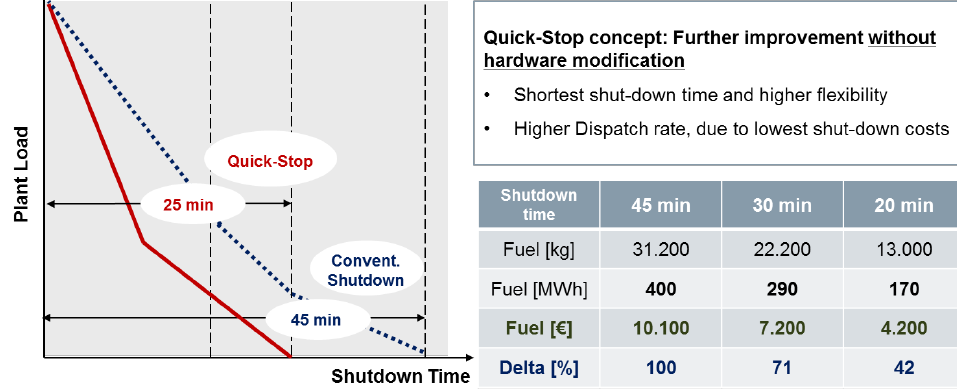
Figure 12. Quick-Stop Test at Lausward CHP